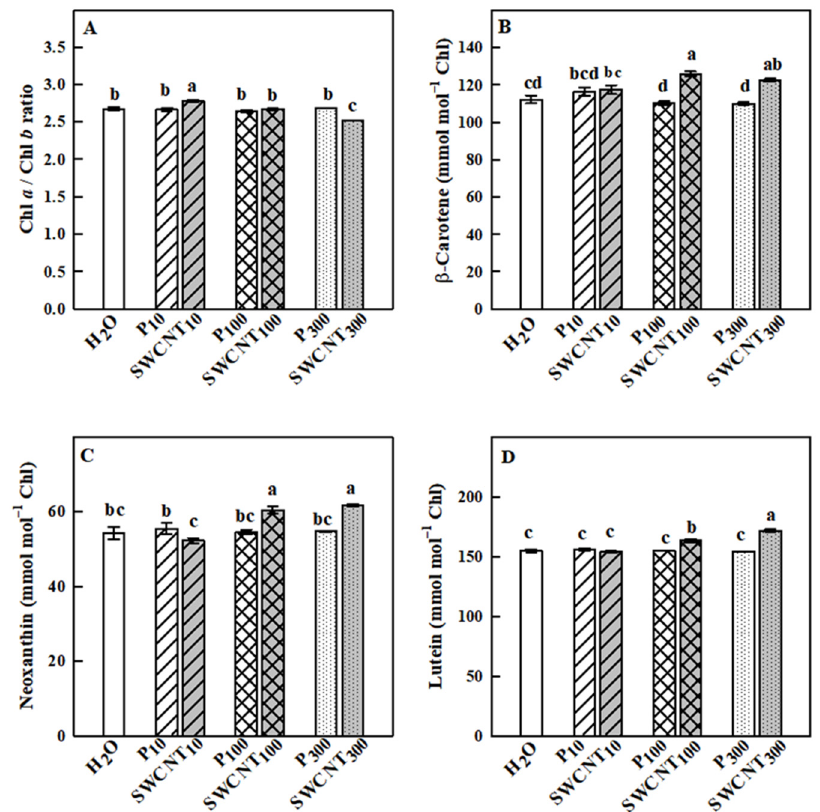
Figure 8. Effect of SWCNTs on chlorophylls and carotenoids. Chl a/Chl b ratio ( A ) and concentration of ß-carotene ( B ), neoxanthin ( C ) and lutein ( D ) of pea leaves seven days after spraying with different concentrations of “Pluronic” P–85 (P 10,100,300 ) and SWCNTs (SWCNT 10,100,300 ). Plants sprayed with H 2 O served as the control. Data are means ± SE ( n = 6). One-way analysis of variance (ANOVA) with a between-subjects factor was performed to assess statistically significant mean differences. Mean separation was performed using a Tukey’s test and statistically different means at the 5% level ( p < 0.05) are indicated with different letters.